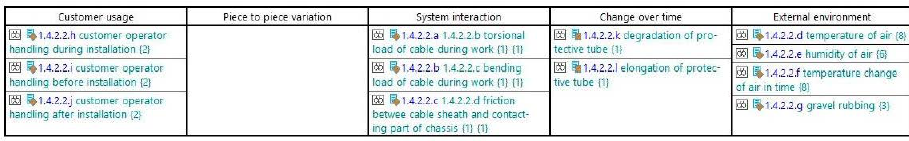
Figure 7. The P-Diagram that is used for classifying the